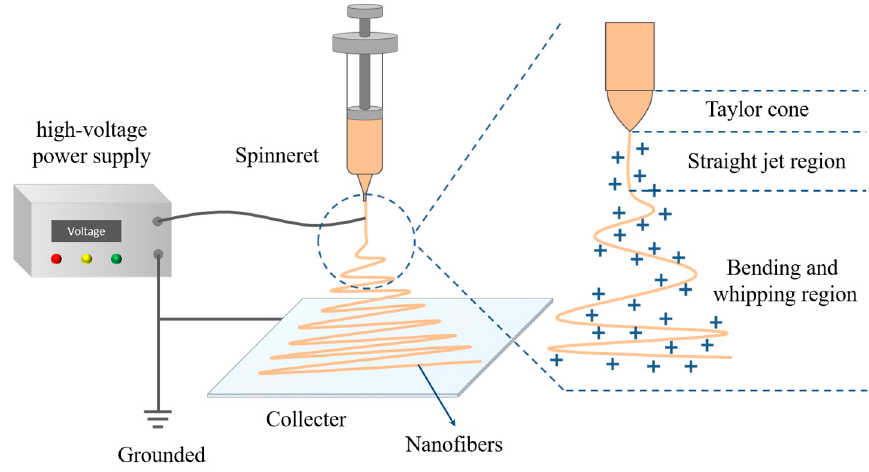
Figure 1. A process diagram for electrospinning.